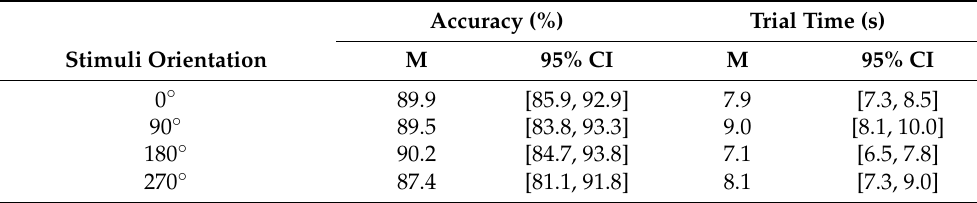
Table 3. Accuracy and trial time in testing for each stimuli orientation.